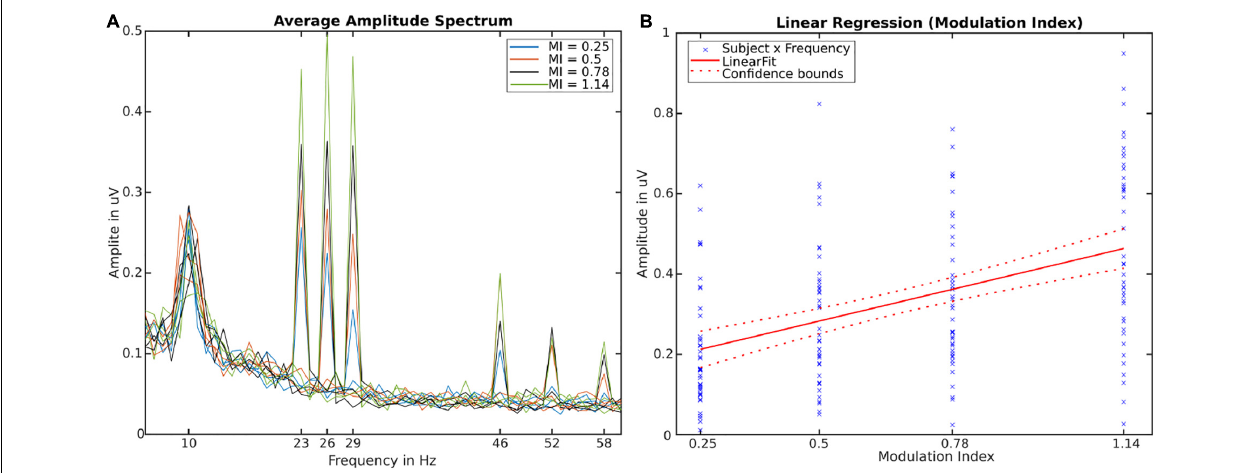
FIGURE 2 | (A) Amplitude Spectra averaged over participants, channels and trials. Twelve individual lines depict stimulation conditions (frequency x modulation index). (B) Linear regression fit using modulation index (independent of frequency and subject) as predictor for the SSVEP-Amplitude [ R 2 = 0.2, F (1,166) = 42.55, p < 0.001]. Crosses depict all individual values for subjects × frequencies.